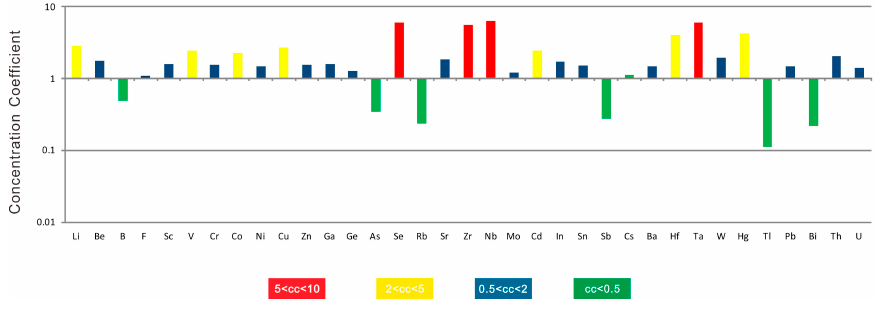
Figure 7. Concentration coefficients (CC) of trace elements in the Zhongliangshan coals, normalized by average trace element concentrations in the word hard coals [44].